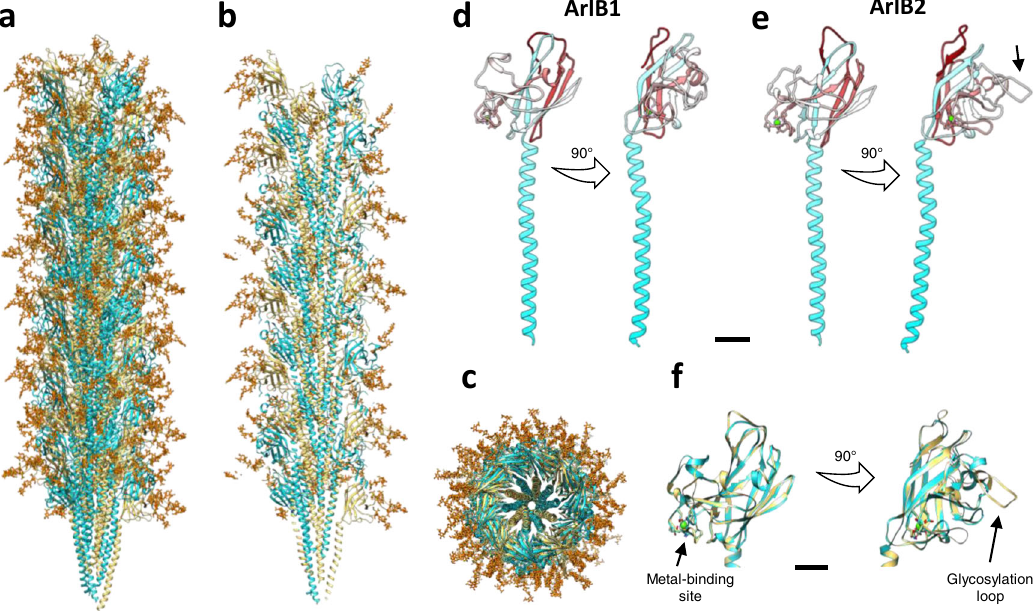
Fig. 2 Atomic model of the M. villosus archaellum fi lament. a – c Atomic model of the archaellum fi lament with glycosylation in side view ( a ) and cross- section parallel ( b ) and perpendicular ( c ) to the fi lament ’ s long axis. ArlB1 is in cyan, ArlB2 in sand, and glycosylation in orange. Scale bar, 50 Å. d , e Atomic models of ArlB1 ( d ) ArlB2 ( e ) in ribbon representation and cyan-white-maroon colour scheme (N-terminus, cyan; C-terminus, maroon). The arrow in e highlights the “ glycosylation loop ” . f Superposition of the ArlB1 (cyan) and ArlB2 (sand) head domain with the metal-binding site and “ glycosylation loop ” highlighted. Scale bar in d , e and f , 10